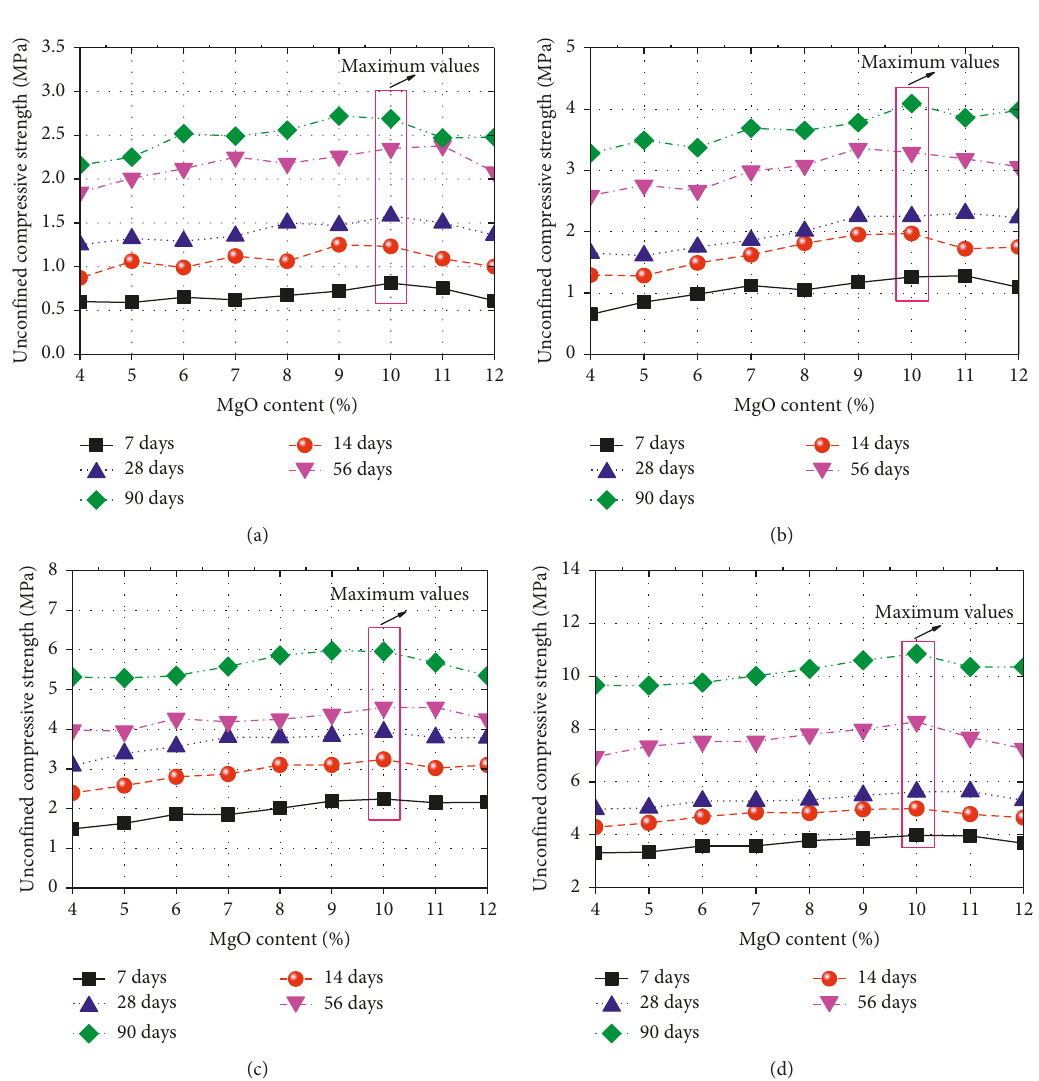
Figure 4: The influence of MgO content on the strength of solidified saline soil. (a) Adding 7% solidifying material. (b) Adding 10% solidifying material. (c) Adding 15% solidifying material. (d) Adding 20% solidifying